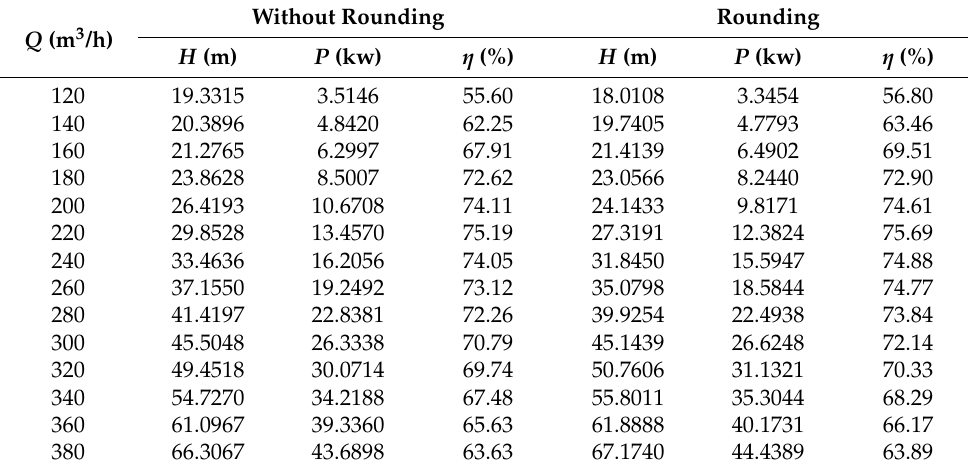
Table 4. Comparison of PAT without rounding and with rounding at 1250